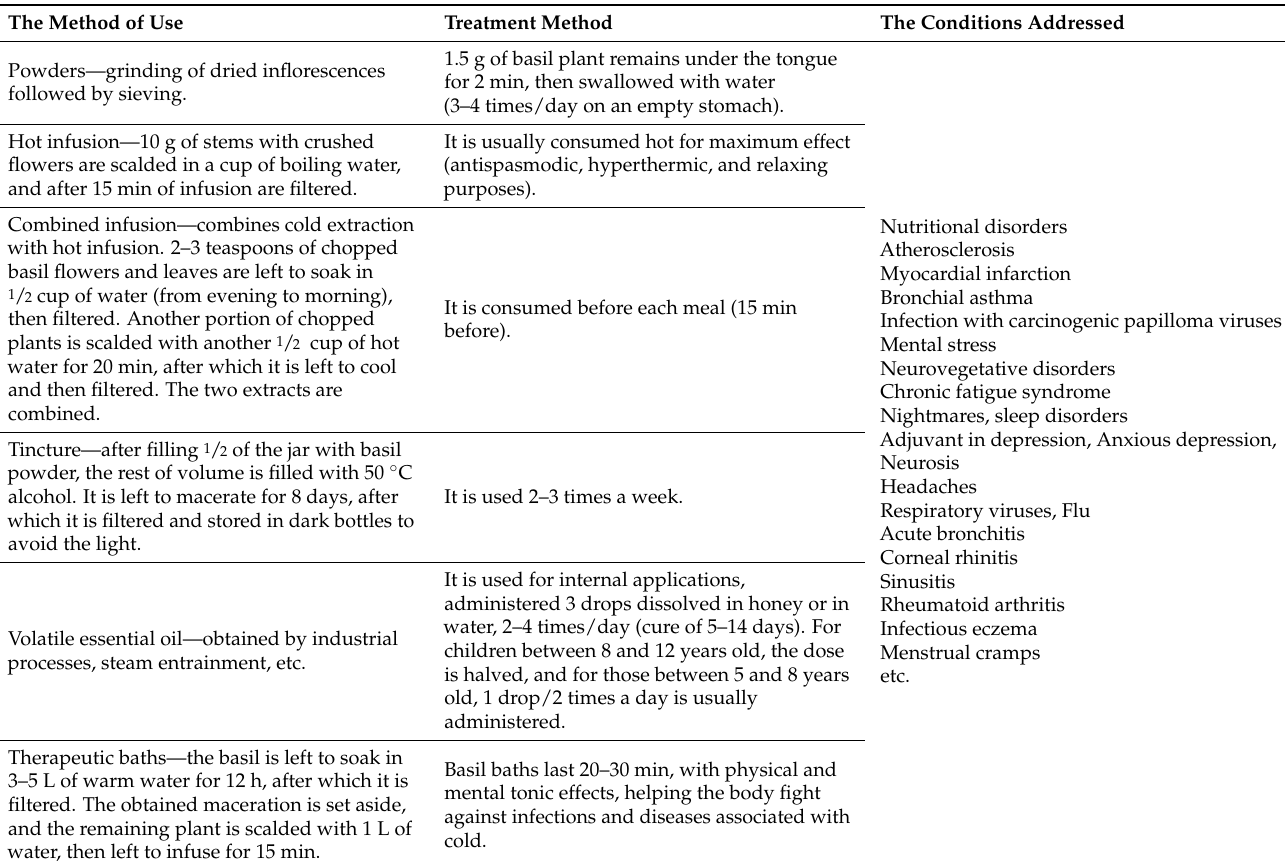
Table 1. Main methods of using basil in traditional